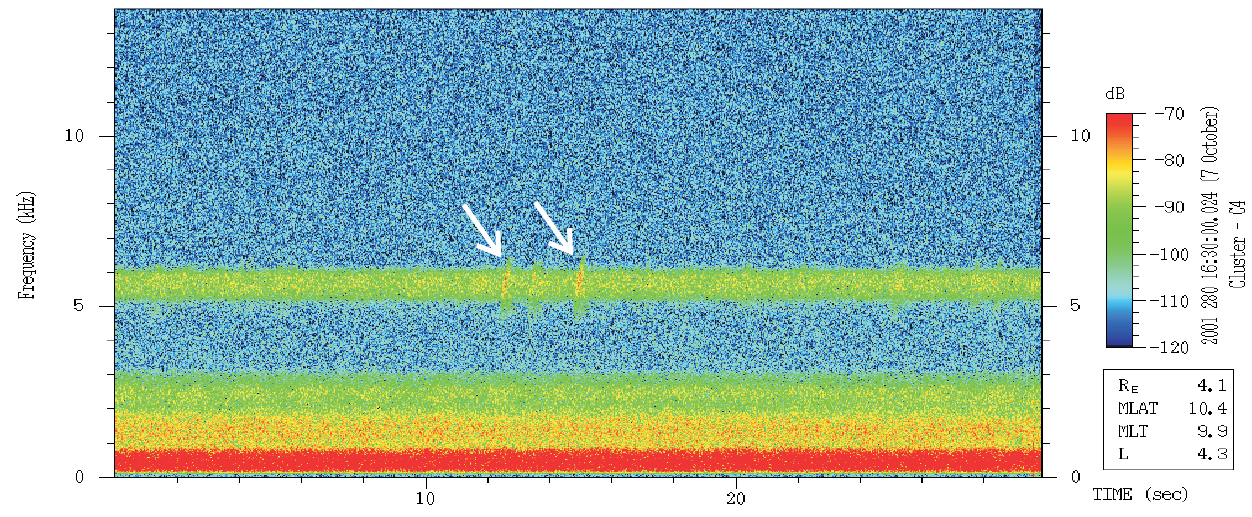
Fig. 2. High time resolution WBD electric field spectrogram measured by C4 on 7 October 2001, from 16:00:00.024 UT to 16:00:30.024 UT. The banded hiss-like emission (BHE) is observed just above 5kHz. Two rising tones, possibly whistlers, are embedded in this BHE. They are pointed out by white arrows around 16:00:12 UT and 16:00:15 UT.